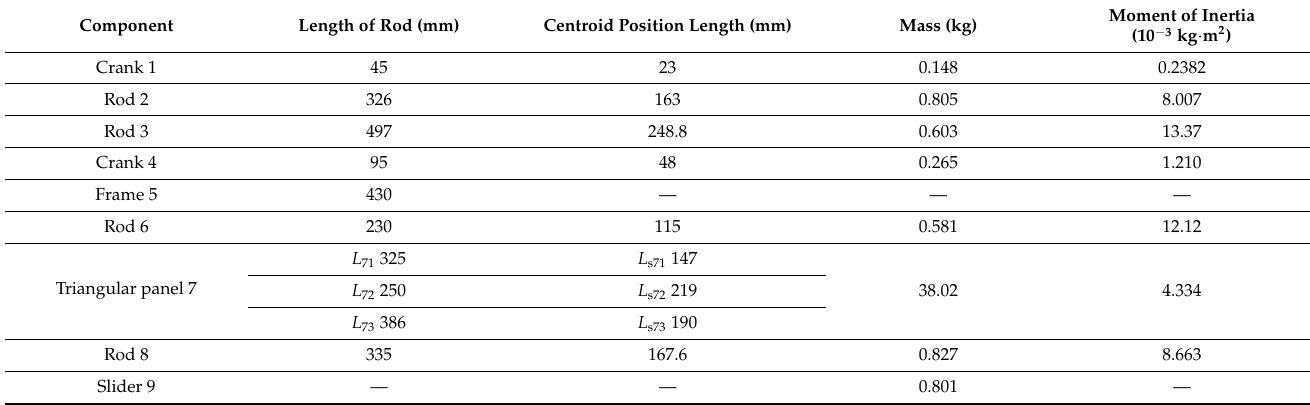
Table 2. Geometric and inertial